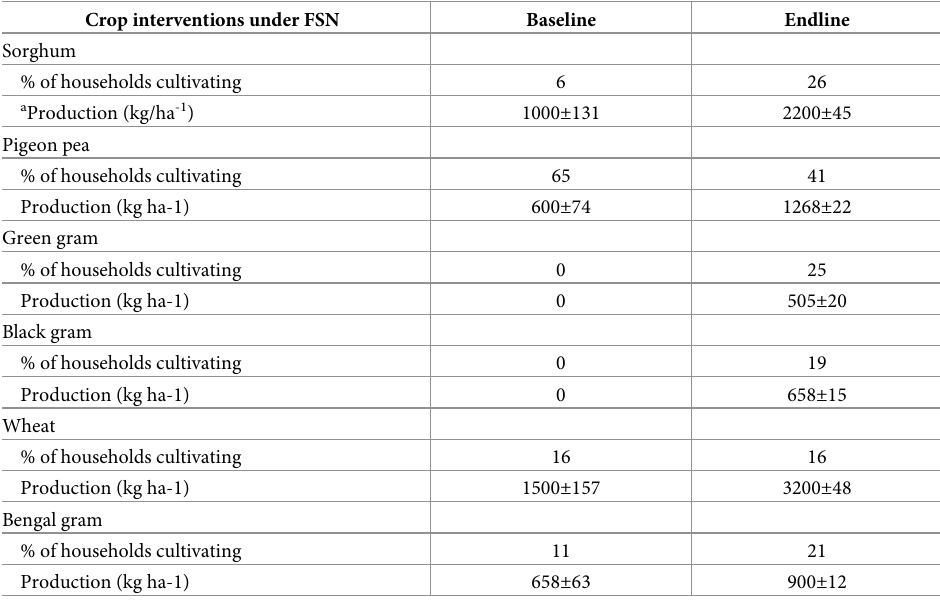
Table 5. Comparison of FSN crop interventions, cultivation and production status between Baseline (2014) and Endline (2017), Wardha (N = 158). Crop interventions under